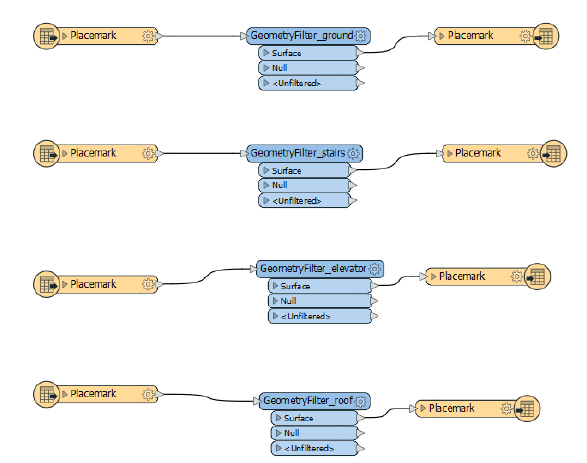
Figure 4. The workflow of data conversion